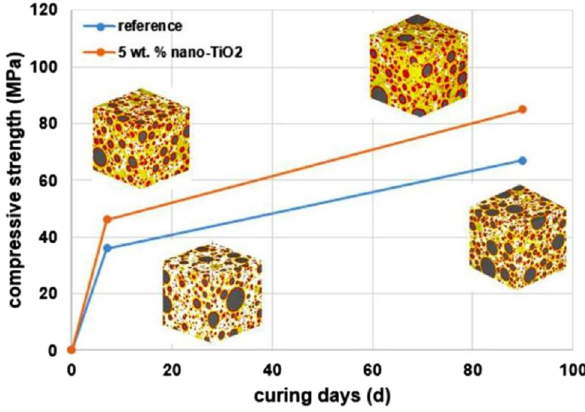
Figure 5: Simulated microstructure of NT - modi fi ed GPC at di ff erent maintenance ages [ 26 ]